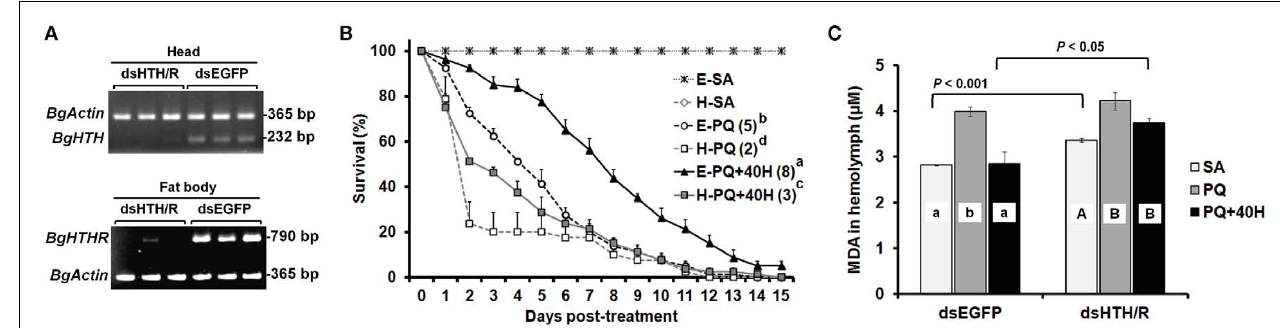
The median survival time (days) is indicated in the parenthesis of each treatment group. (C) Lipid peroxidation 4h after PQ treatment. MDA, malondialdehyde as an indicator of lipid peroxidation. Results are presented as the mean ± SEM ( n = 4 per treatment group). Different letters on the histogram indicate significant differences within the same dsRNA treatment. Two-tailed t -test was performed between different dsRNA